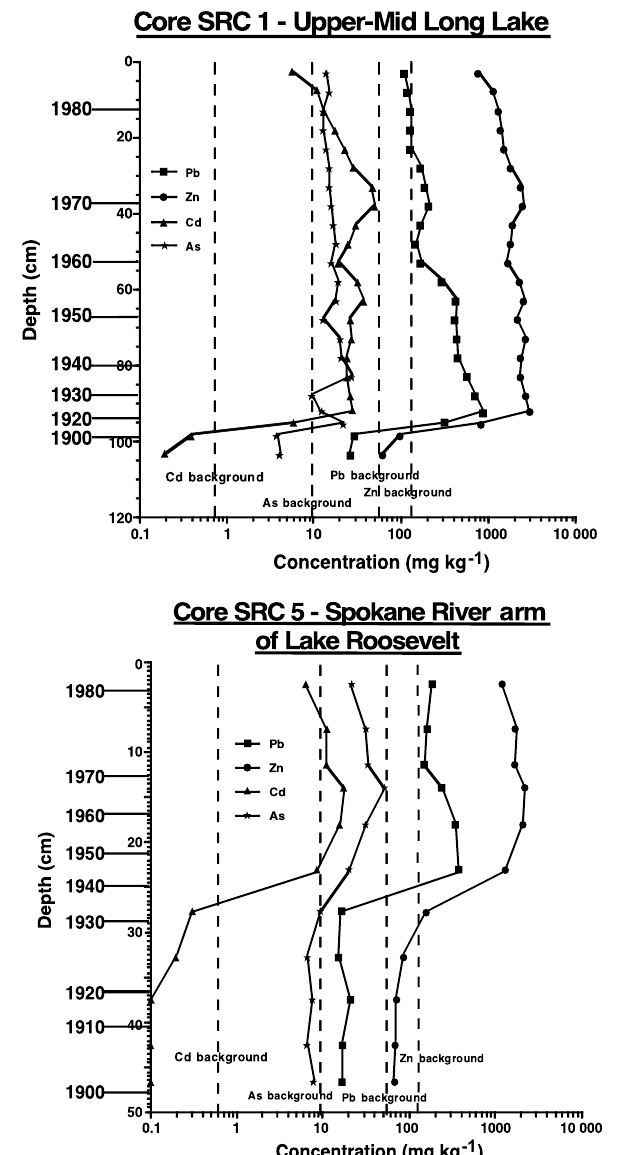
Figure 2. Plots of chemical data from two sediment cores collected in impoundments along the Spokane River, Washington,